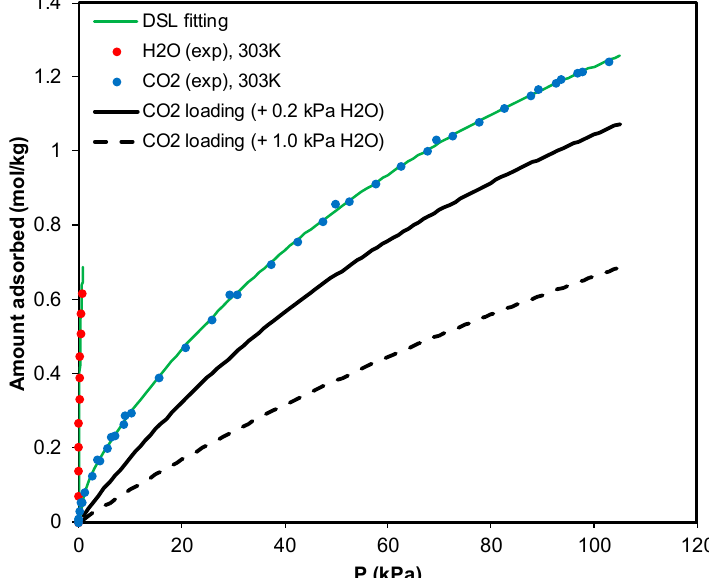
Figure 11. Adsorption equilibrium isotherms of H 2 O on ZSM-5 extrudates at 303 K ( ♦ ), 323 K ( ▲ ), and 343 K ( ■ ). Solid lines represent the dual-site Langmuir model fittings.